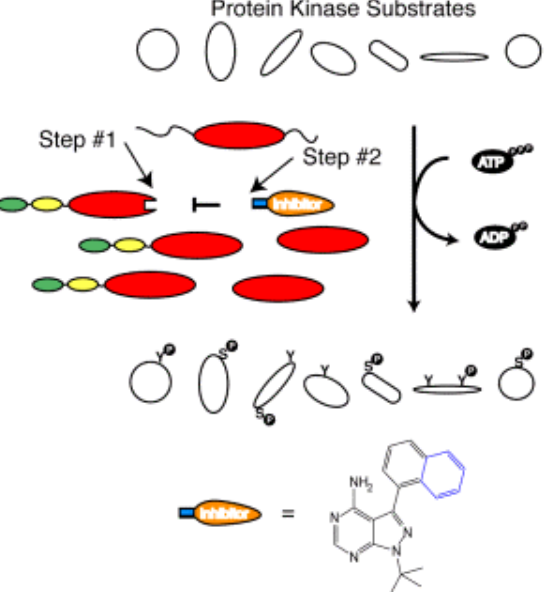
FIGURE. Additional color illustrations pertaining to this Report may be inspected by visiting